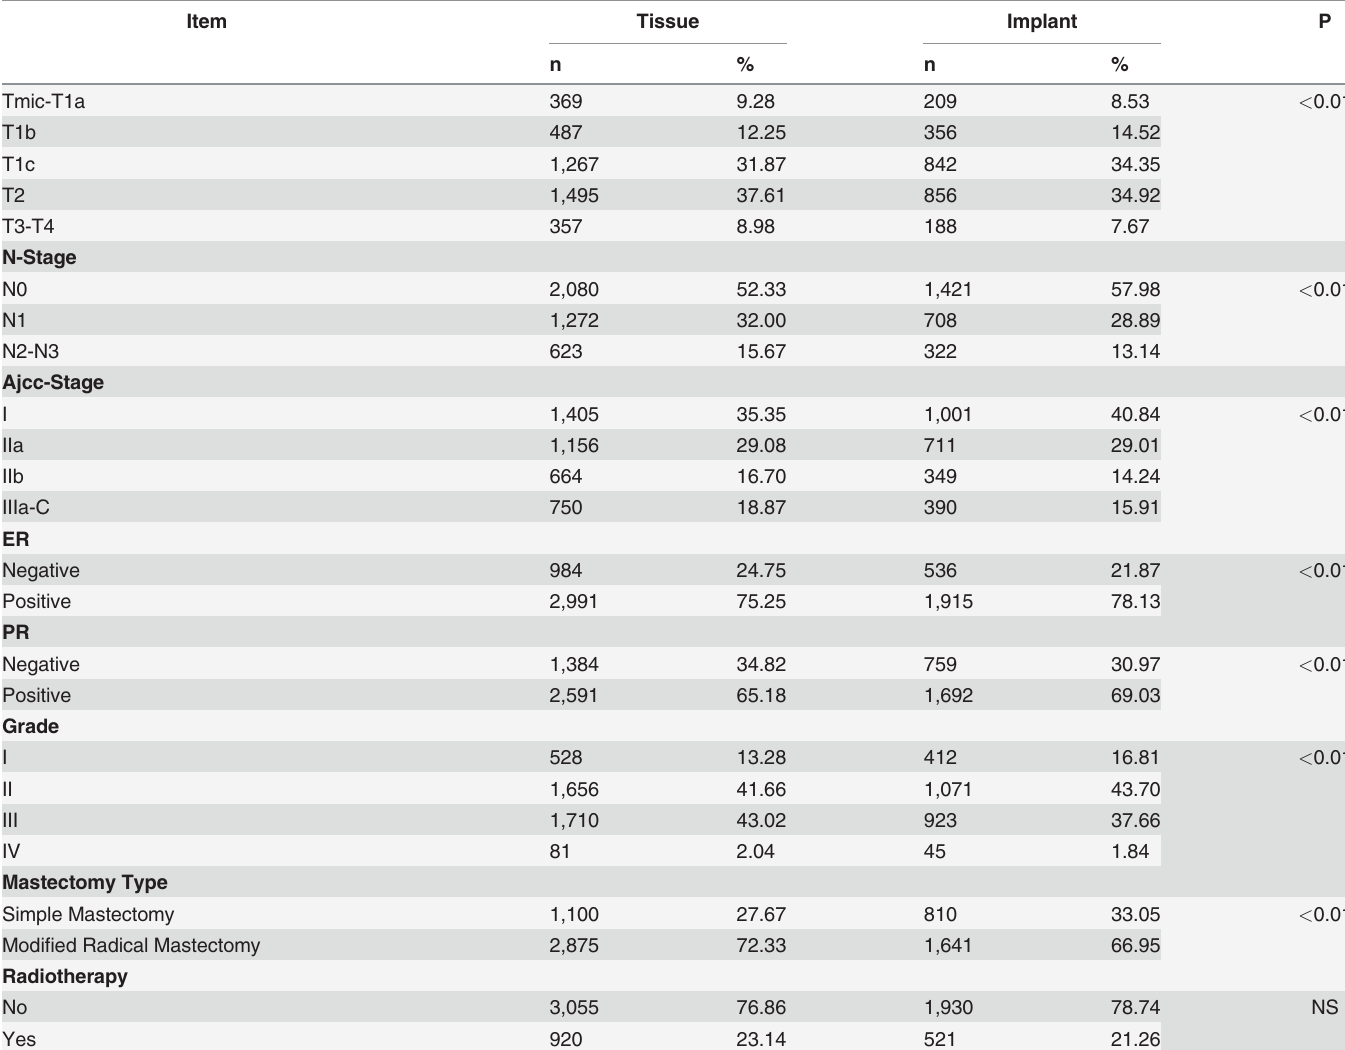
In univariate analysis (S1 Table), we observed that African American (vs. White), age < 50 yrs, Northern plains (vs. East) area, divorced/separated/single/widowed (vs. married), infiltrating duc- tal carcinoma (vs. lobular carcinoma), higher T-stage, higher N-stage, negative ER, negative PR, higher tumor grade, modified radical mastectomy (vs. simple mastectomy), radiotherapy, and tis- sue reconstruction (vs. implant) were all associated with decreased BCSS. These factors were all included in the multivariate analysis. The cumulative BCSS rates in the tissue and implant cohort were 91.4% and 93.0% at 5 years and 84.3% and 86.7% at 10 years (log-rank test, P = 0.003), re- spectively. The cumulative non-BCSS rates in the tissue- and implant- cohorts were 98.7% and 98.0% at 5 years and 96.1% and 94.2% at 10 years (log-rank test, P = 0.002),